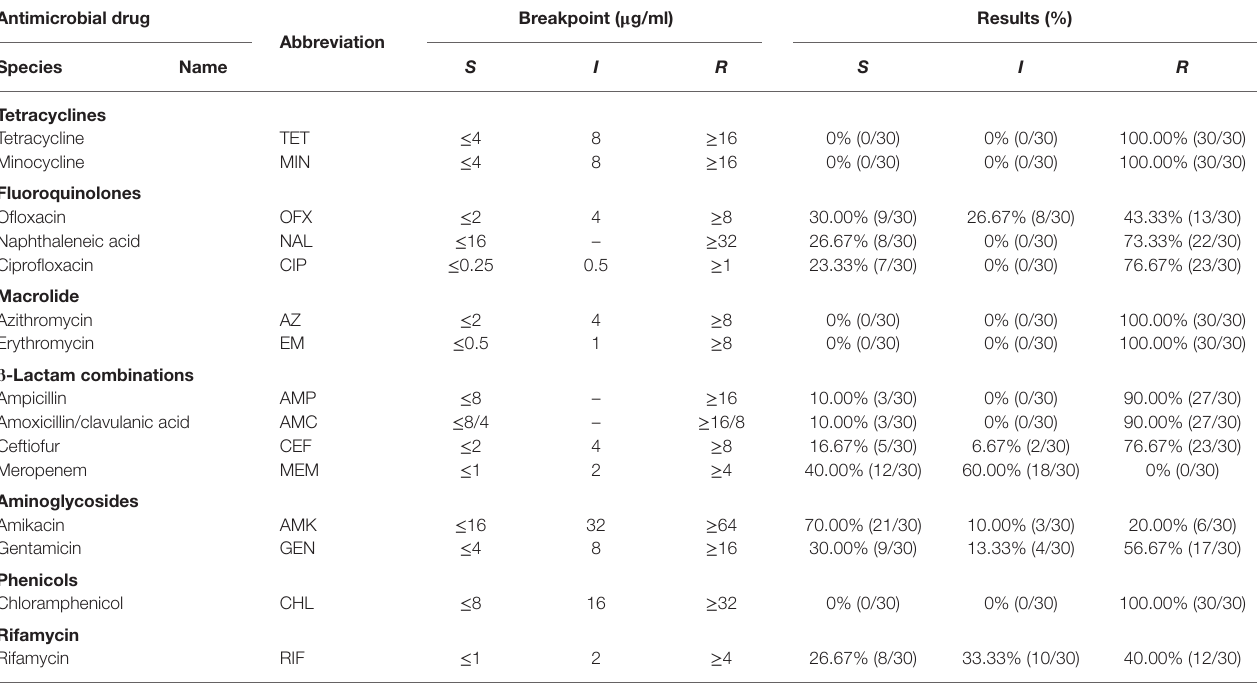
TABLE 2 | Antimicrobial susceptibility tests for P. mirabilis strains used in this study ( n = 30). Antimicrobial